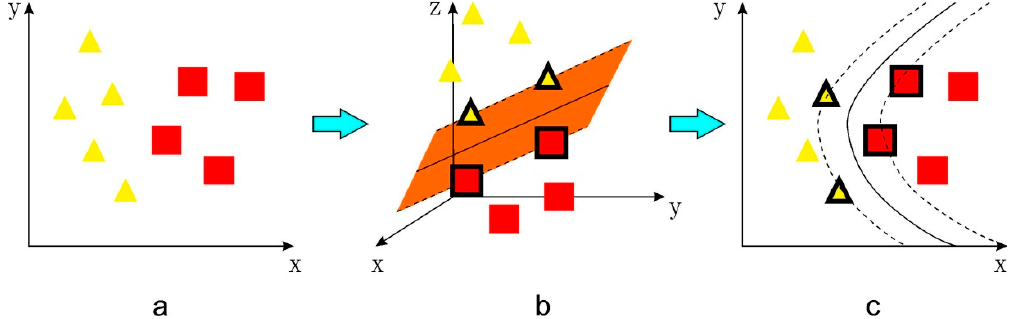
Figure 5. Creation of the boundary for a non-separable case. ( a ) Two linearly inseparable classes in two dimensions. ( b ) Projection onto a higher-dimensional space using the kernel function, where it is possible to separate the classes using a plane, with three support vectors indicated. ( c ) Projection back into two dimensions. [35].